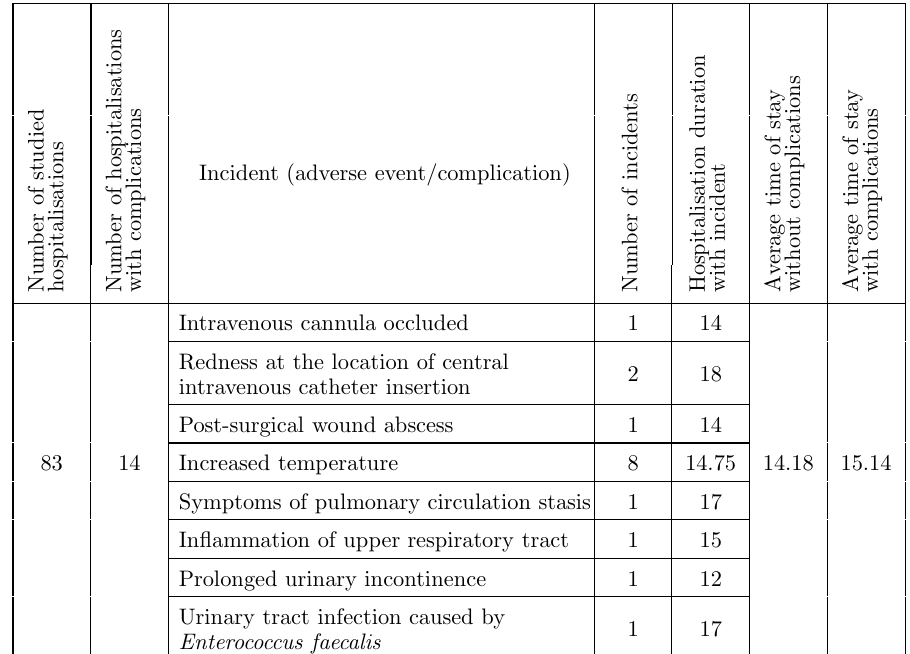
Table 2. Adverse events identified during the analysis of the H05 group in the Injury and Orthopaedics Surgery Ward